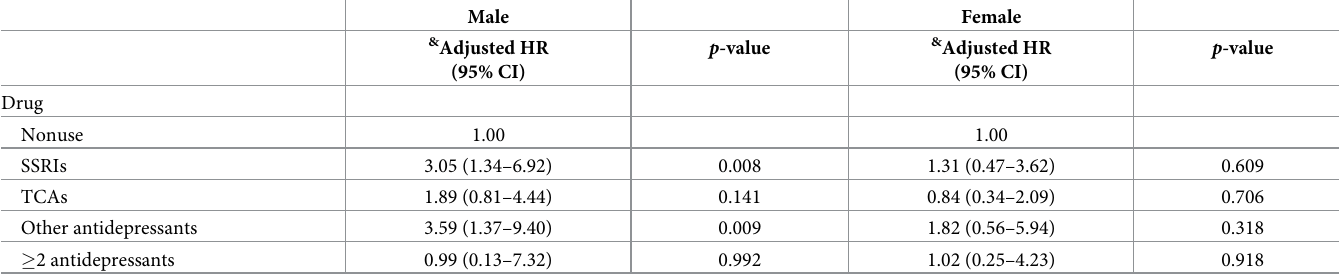
Table 4. Gender-stratified multiple Cox proportional hazards regression analysis of the RLS risk in IBS patients with antidepressant